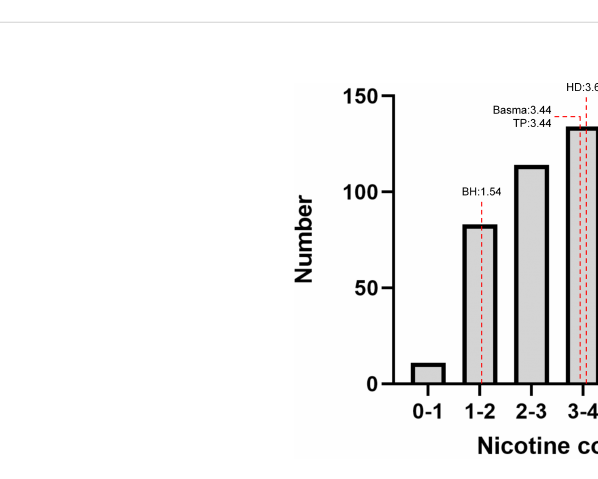
FIGURE 2 Phenotypic distribution of 8 parents and 560 MAGIC lines. Eight parents were shown as dotted